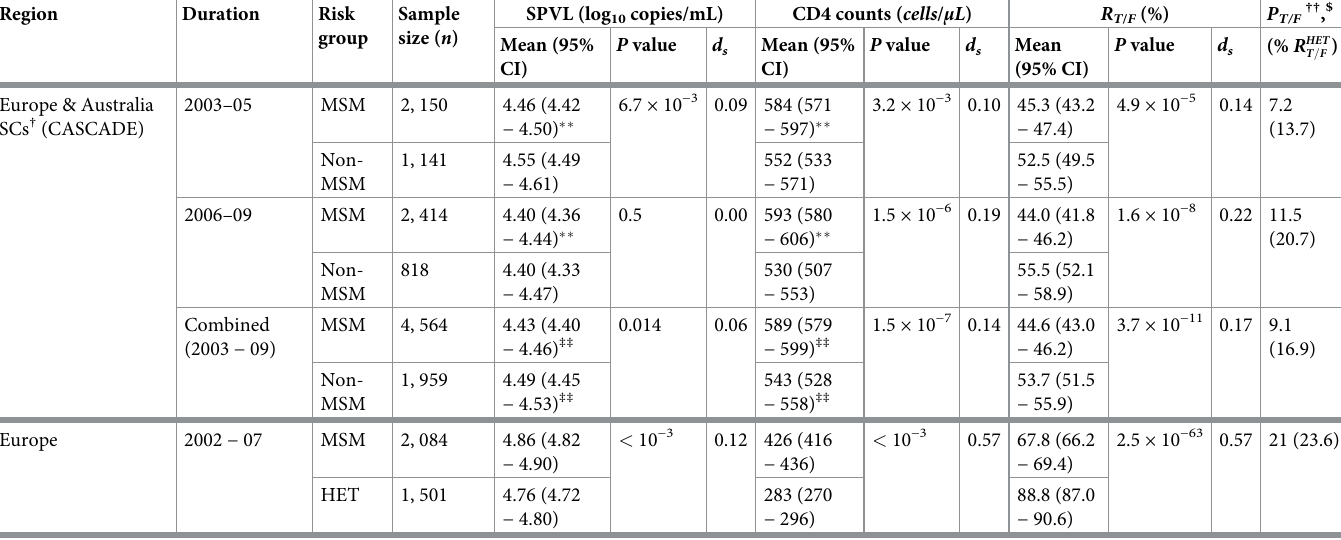
� Viral load in primary infection too did not show significant differences between the groups in a study that recently reported these measurements [3]. We extracted the reported viral load data, from 16 MSM and 17 HET in Fiebig stages II and III, all infected during 1990–02 with subtype B, and found that the mean viral loads (SD)